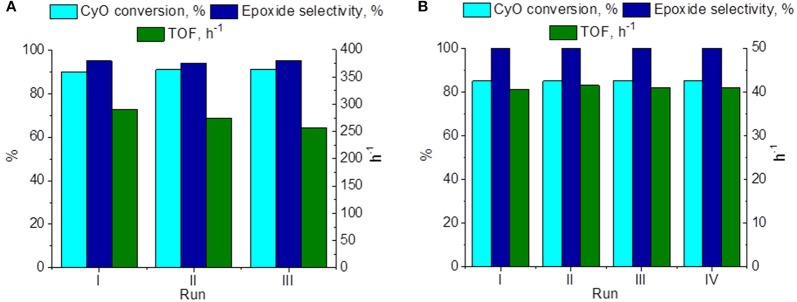
Recycling performance of (A) 15 wt. % PW4/CNTs and (B) 5 wt. % PW4/CNTs in CyO epoxidation. Reaction conditions: [CyO] = 0.1 M (13 μl), [H2O2] = 0.2 M (20 μl 30% H2O2), PW4/CNTs 10-30 mg (0.7 μmol PW4), DMC 1 ml, 50°C.